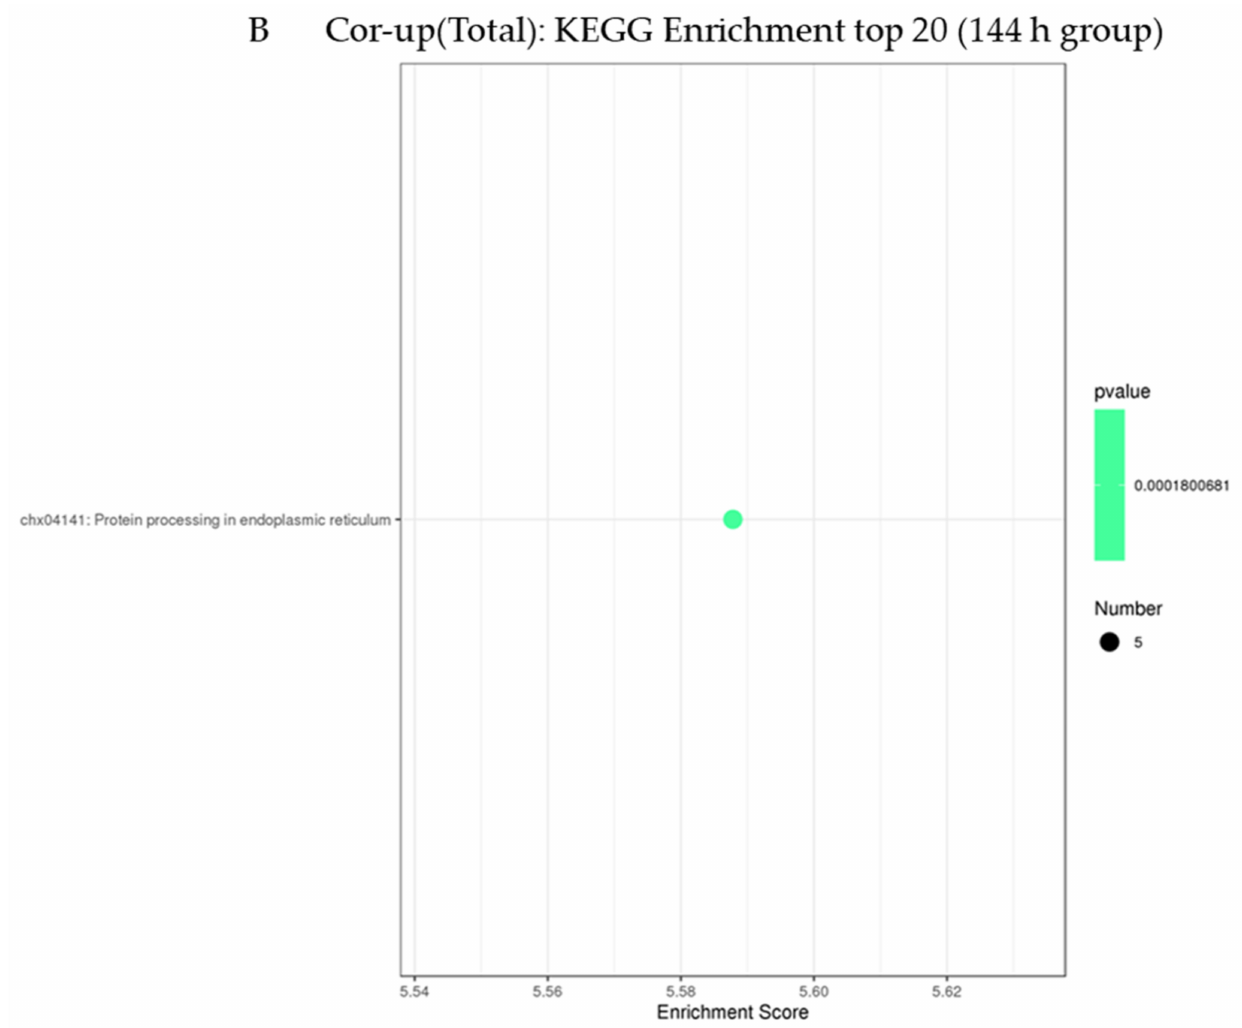
Figure 5. KEGG (the Kyoto Encyclopedia of Genes and Genomes) pathway classification and functional enrichment for the predicted co-upregulated proteins and transcriptome in different groups (( A ) means 72 h, ( B ) means 144